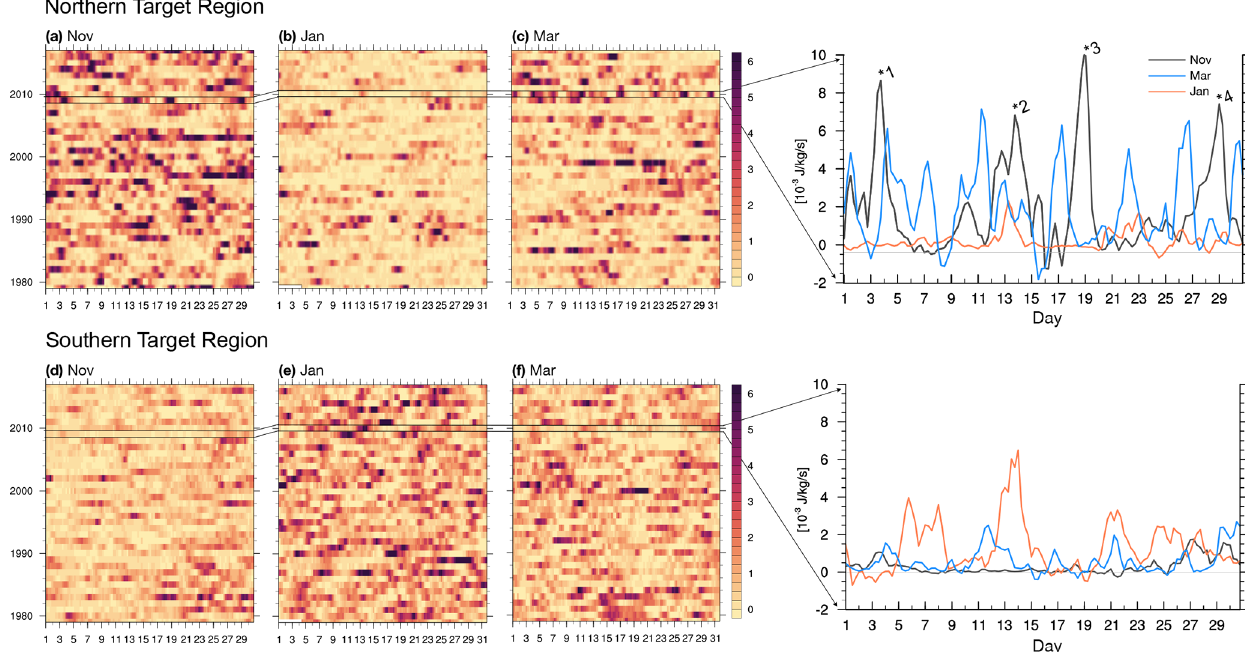
Figure 4. Baroclinic conversion at 500hPa (10 − 3 Jkg − 1 s − 1 ) averaged over the (a–c) northern and (d–f) southern target regions shown in Fig. 1 for (a, d) November, (b, e) January, and (c, f) March for the period 1979–2018. Attached on the right side is a zoomed-in image of the individual time series of daily mean values for November (2009), January (2010), and March